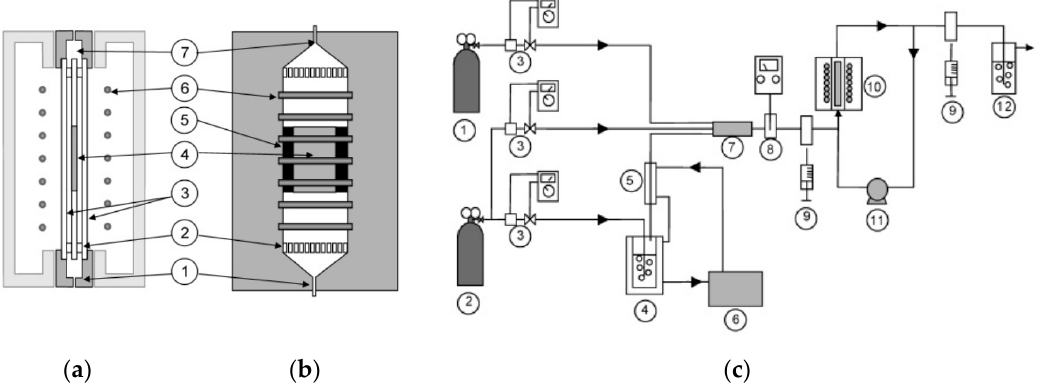
Figure 7. Different views of the photocatalytic air reactor designed by Imoberdorf et al. (2005): ( a ) transversal side cut, ( b ) top, and ( c ) process flow diagrams. Adapted with permission from Reference [83], Copyright (2005), American Chemical Society.